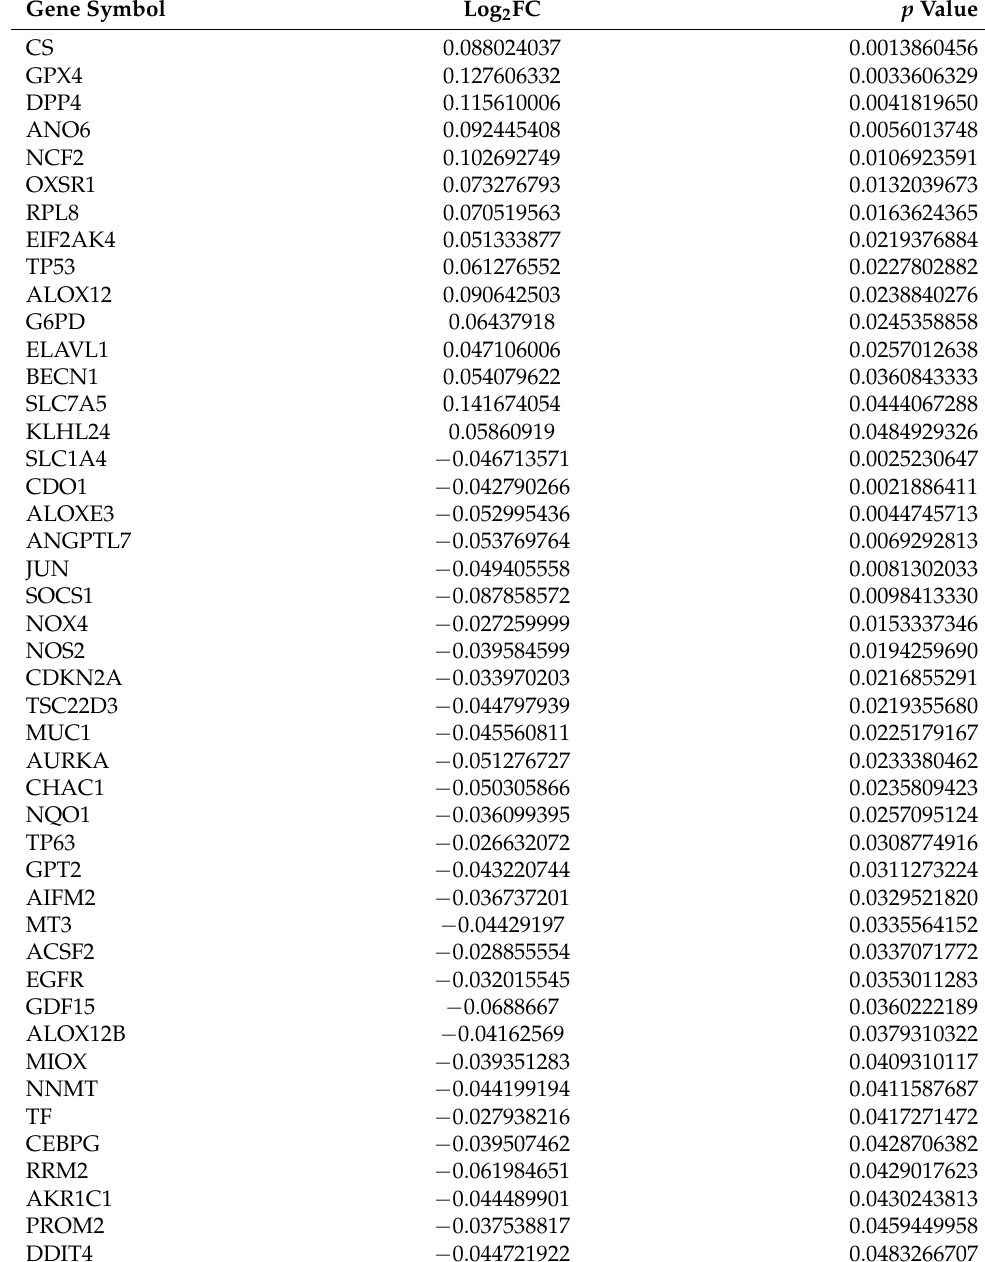
Table 4. Intersection of the DEGs and ferroptosis-related